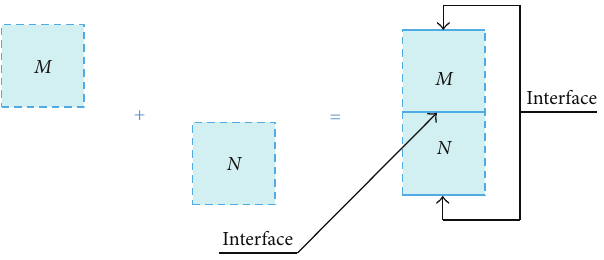
Figure 1: Schematic diagram of the interfacial energy.